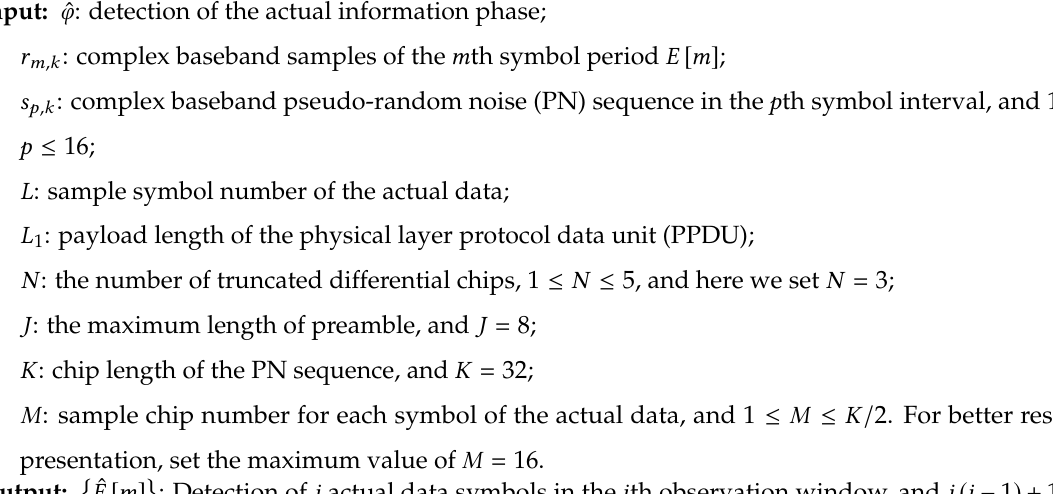
Algorithm 1 The proposed multiple-symbol detection